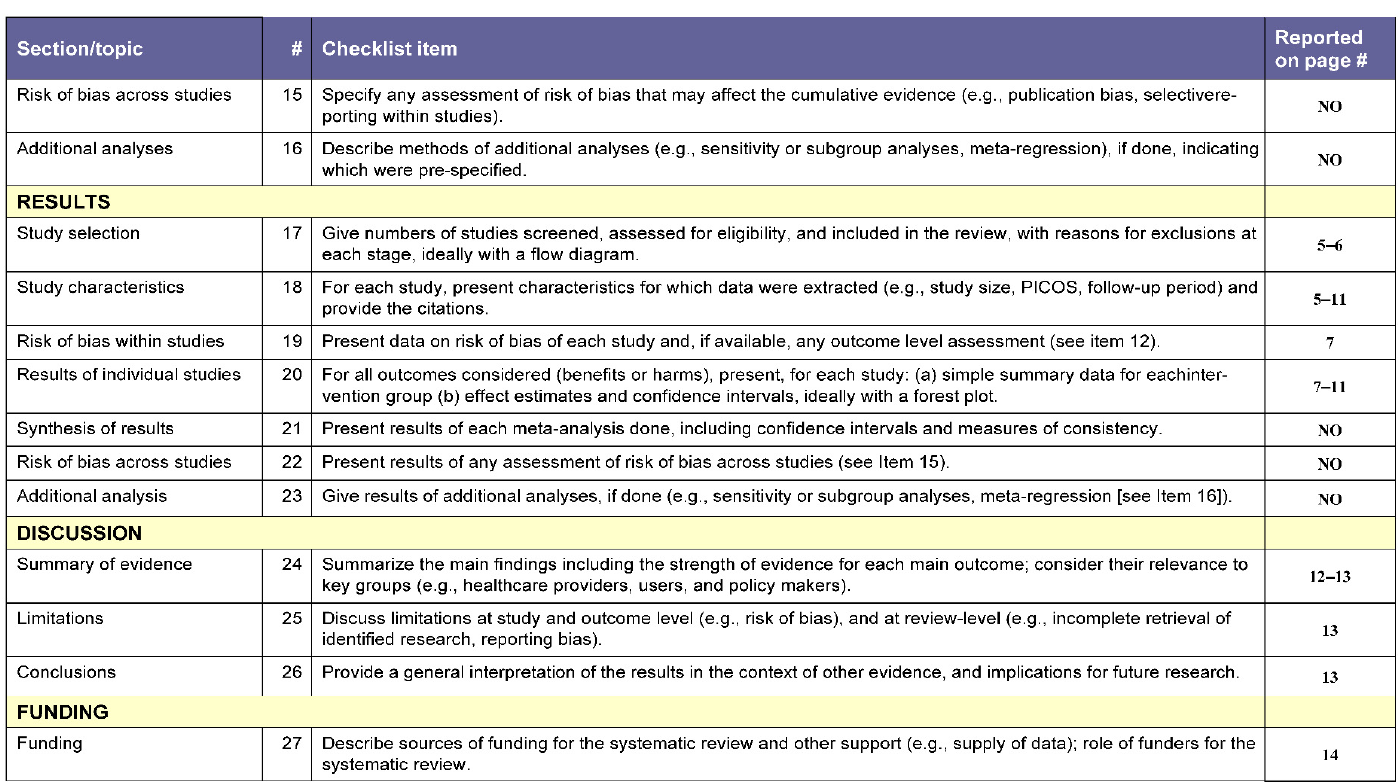
Figure A1. PRISMA Checklist.